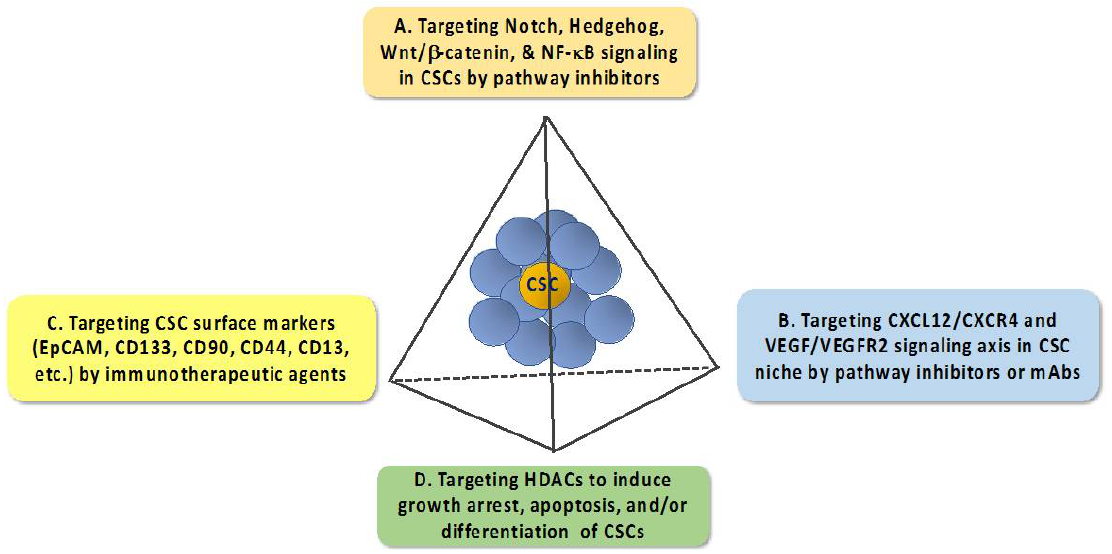
Figure 1. Diagrammatic scheme outlining major anti-cancer stem cell (CSC)